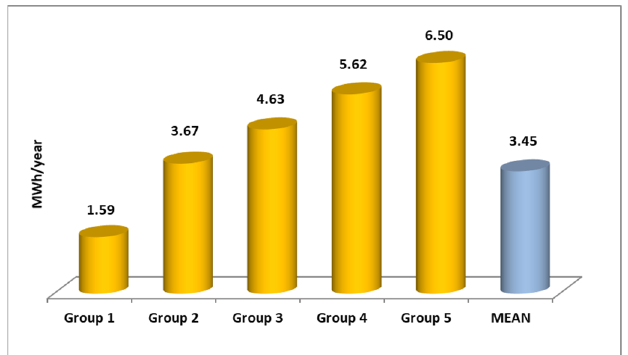
Table 7. Statistical data of inhabitant consumption without the influence of climate.